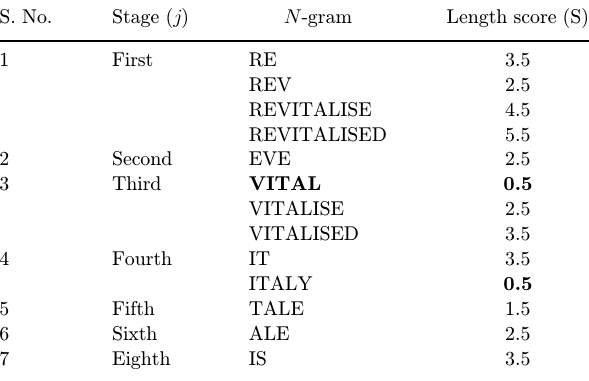
Table 2. Legitimate N -grams as output at corresponding